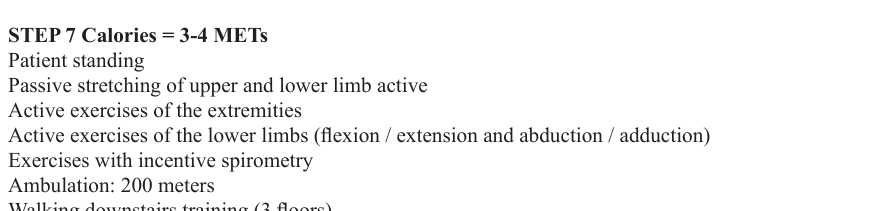
Ambulation: 160 meters Walking downstairs training (2 floors) STEP 7 Calories = 3-4 METs Patient standing Passive stretching of upper and lower limb active Active exercises of the extremities Active exercises of the lower limbs (flexion / extension and abduction / adduction) Exercises with incentive spirometry Ambulation: 200 meters Walking downstairs training (3